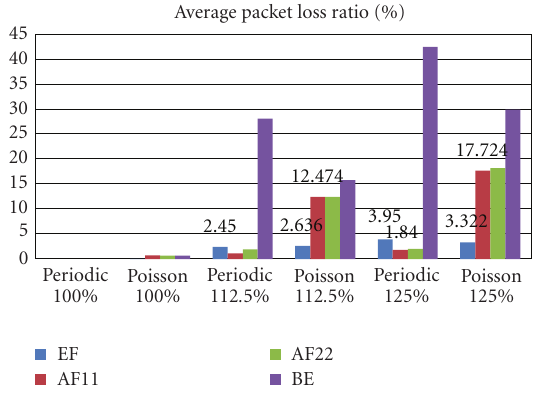
Figure 11: Average packet loss ratio.